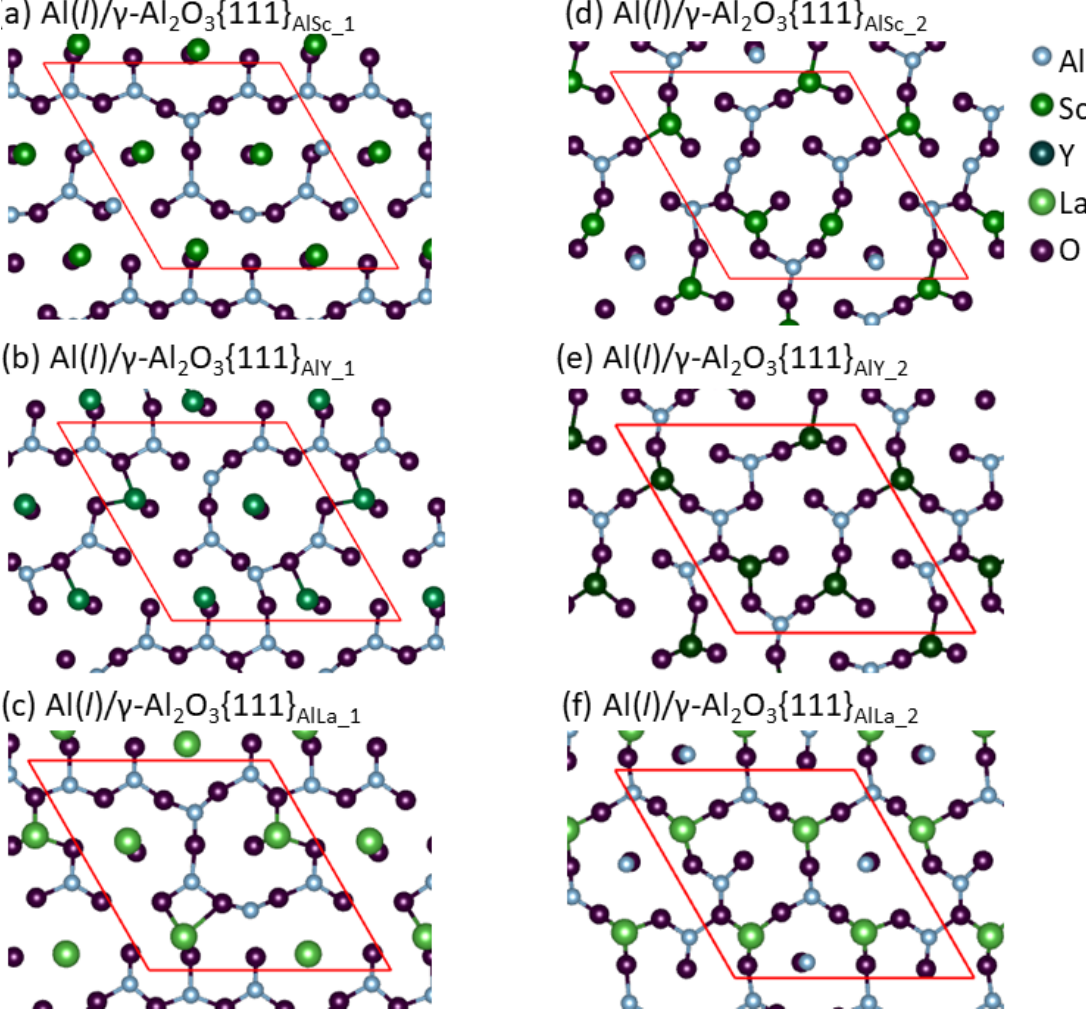
Figure 3. Atomic arrangements of the outmost O, the terminating Al and the Group 3 atoms at the Al( l )/ γ -Al 2 O 3 {1 1 1} AlM interfaces at simulation 6 ps. The red lines represent the in-plane axis. At Al( l )/ γ -Al 2 O 3 {1 1 1} AlM_1 , the Group 3 atoms are dominantly on top of O, whereas at Al( l )/ γ -Al 2 O 3 {1 1 1} AlM_2 , they are positioned mainly on O triangles. ( a ) Al( l )/ γ -Al 2 O 3 {111} AlSc_1 , ( b ) Al( l )/ γ -Al 2 O 3 {111} AlY_1 , ( c ) Al( l )/ γ -Al 2 O 3 {111} AlLa_1 , ( d ) Al( l )/ γ -Al 2 O 3 {111} AlSc_2 , ( e ) Al( l )/ γ -Al 2 O 3 {111} AlY_2 , ( f ) Al( l )/ γ -Al 2 O 3 {111} AlLa_2 .